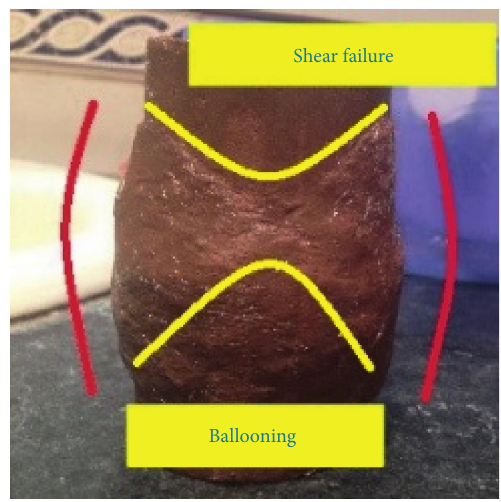
Figure 23: Appearances of fiber-reinforced soils after failure.